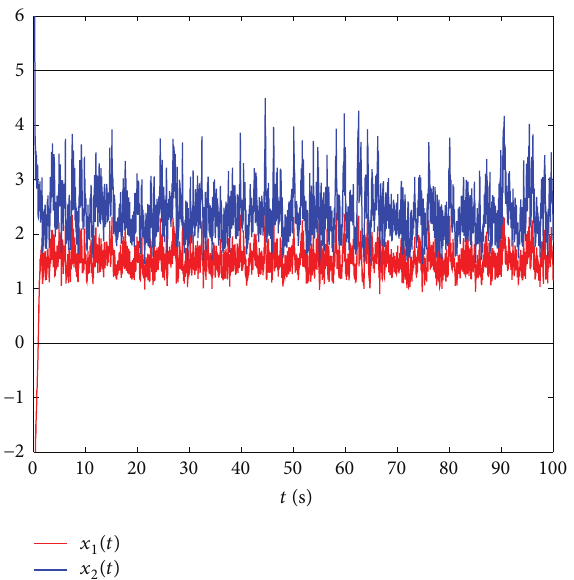
Figure 3: The mean-square uniformly ultimate boundedness.